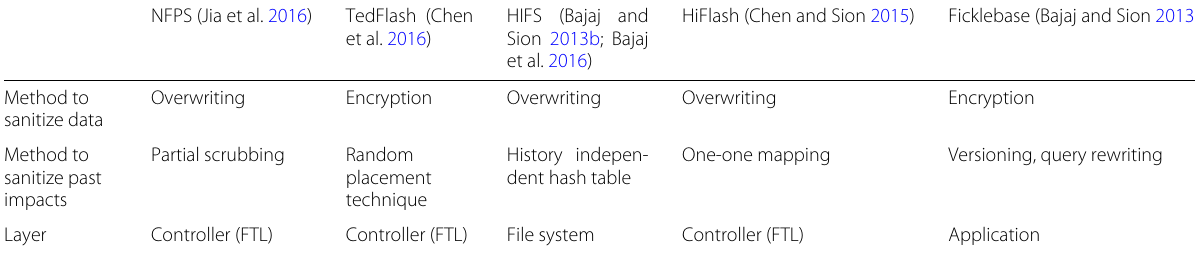
Table 5 Comparison of features offered by secure deletion approaches designed to handle impacts created by past existence of the deleted